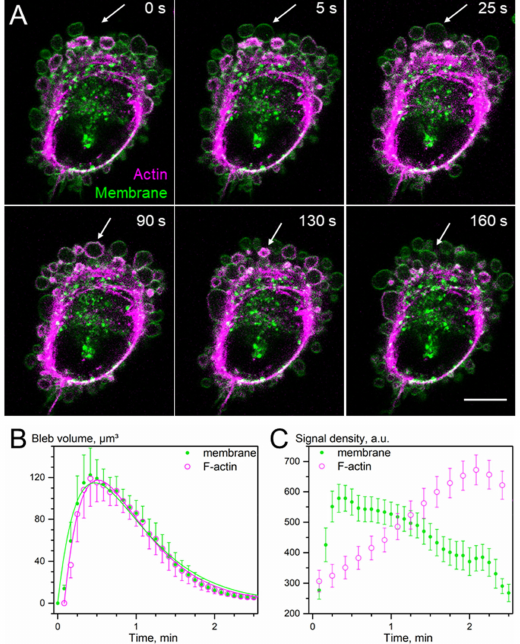
Figure 4. Membrane blebs in DK-MG cells. ( A ) Live-cell imaging of a representative blebbing DK-MG cell stained for F-actin (magenta) and plasma membrane (green) reveals individual bleb dynamics over time (white arrow). Scale bar: 10 µ m. ( B ) Statistically summarized biphasic kinetics of membrane and F-actin formation shows a temporal shift in bleb growth. ( C ) Plotting of fluorescence intensity of plasma membrane and F-actin signals in individual blebs over time reveals a lag in F-actin signal build-up compared to the plasma